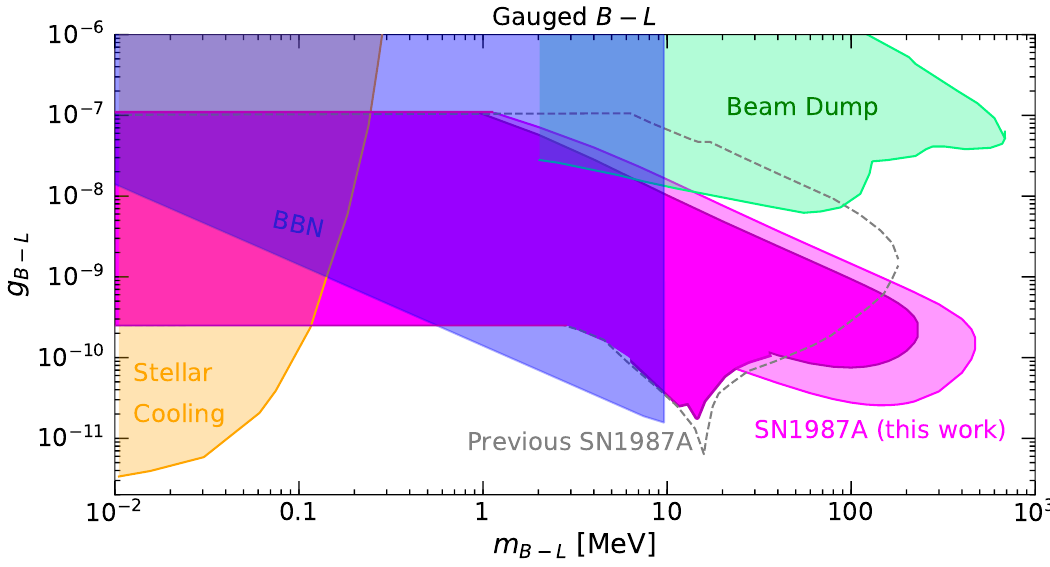
Figure 5. Parameter space for the B − L gauge boson. New SN1987A limit is shown as magenta shaded region. Inner region is conservative calculation, outer is less conservative (see text). Dashed line is previous SN1987A estimate in this region